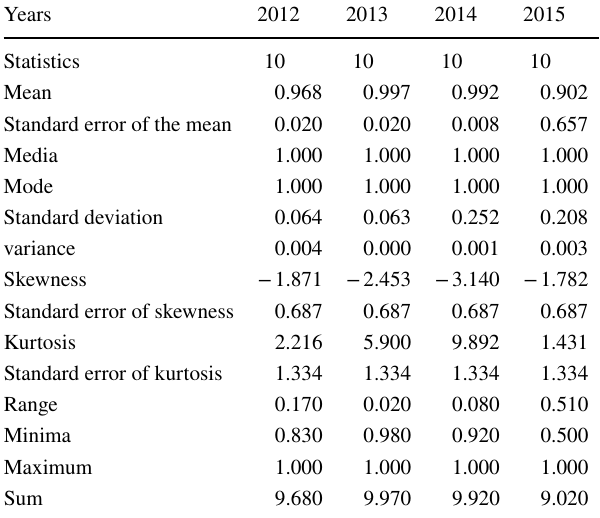
Table 6 Pure technical efficiency distribution in 2012–2015